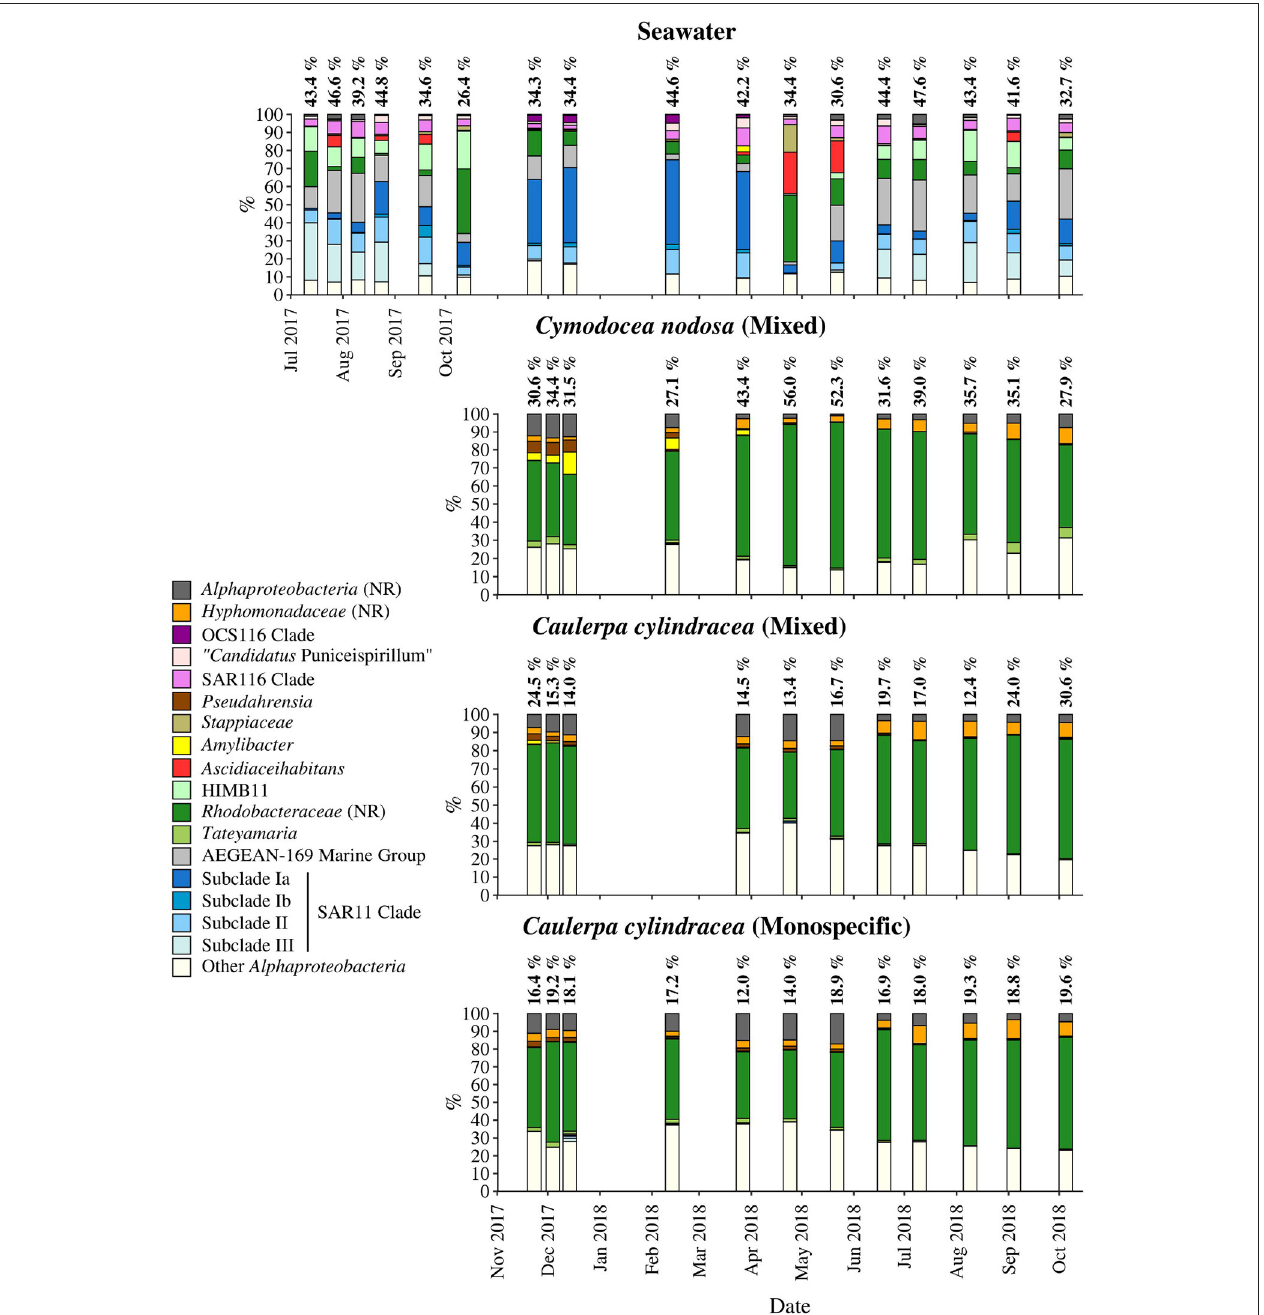
FIGURE 7 | Taxonomic classification and relative contribution of the most abundant ( ≥ 2%) alphaproteobacterial sequences on the surfaces of the macrophytes C. nodosa (mixed settlement) and C. cylindracea (mixed and monospecific settlement) and in the ambient seawater. The proportion of alphaproteobacterial sequences in the total bacterial and archaeal community is given above the corresponding bar. NR – No Relative (sequences without known relatives within the corresponding